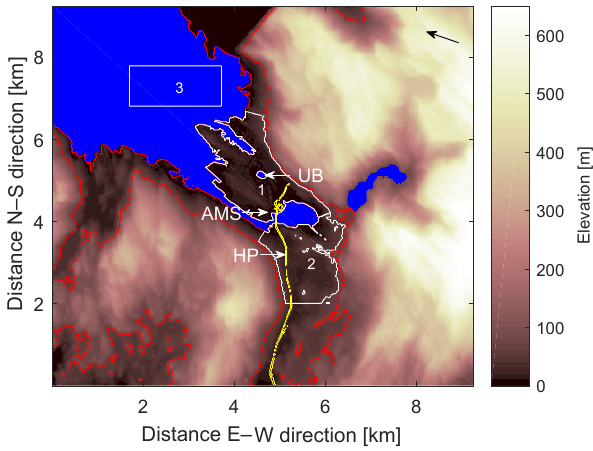
Figure 2. Topographic map of the Bergen area represented in the model simulations. Blue colour indicates water. The white contour line marks the areas 1 and 2 selected for averaging of the wind and passive tracer concentration. The red contour line marks the area of passive tracer emissions in most of the experiments. Both lines are overlapping along the coast. The yellow line represents the main street along the valley, eventually disappearing into a tunnel after having crossed the valley. White arrows indicate the positions of the wind measurements (AMS), and the urban background (UB) and high pollution (HP) reference stations for NO 2 air pollution. The area for averaging of the 2m temperature over the fjord in Table 1 is marked as area 3; averaging of the 2m temperature over the city centre is done separately over areas 1 and 2. The black arrow in the upper right corner indicates the 110 ◦ geostrophic wind direction used for the